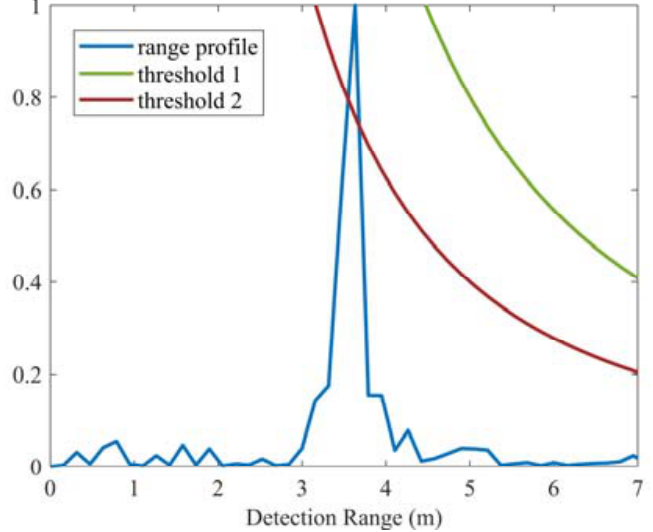
Figure 9. Comparison result processed by the method in [36] of the experiment with a single target.